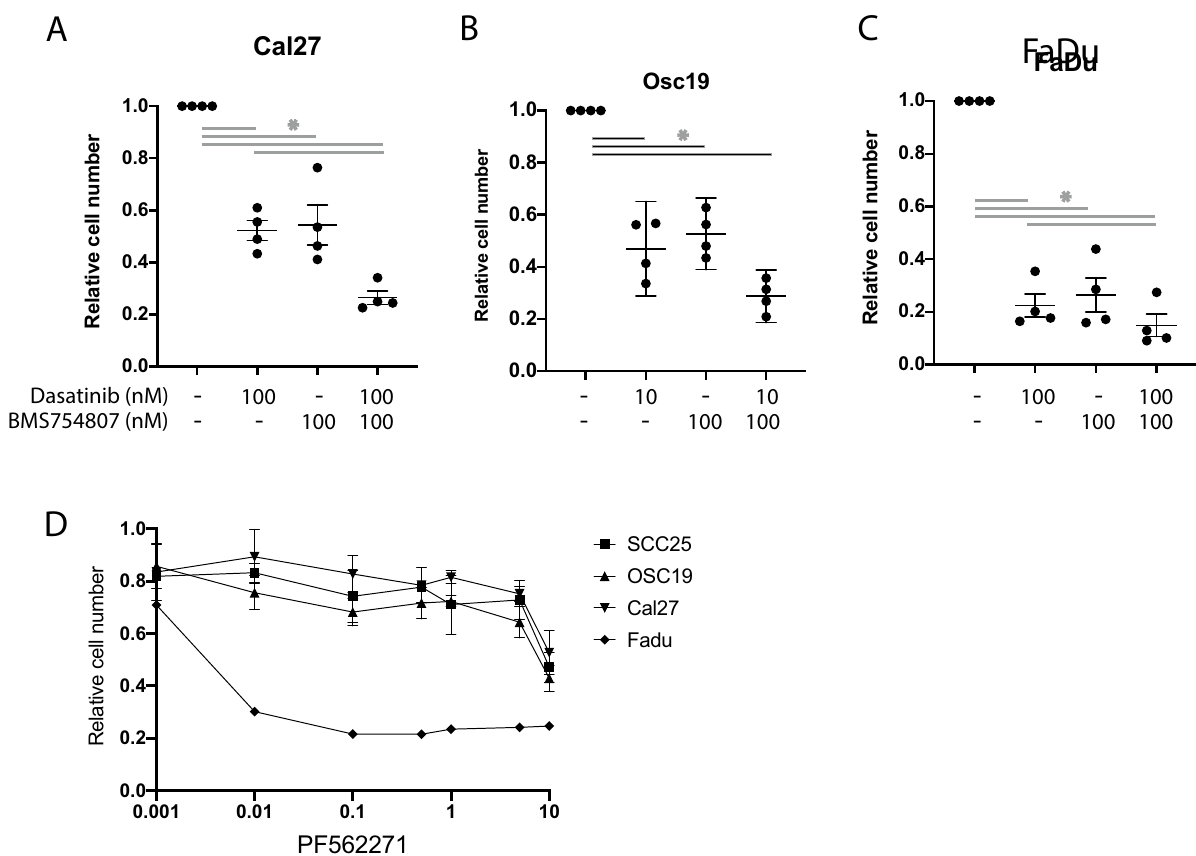
Figure 5. Inhibition of FAK, IGF1R and Src induces cytotoxicity in HNSCC spheroids. ( A – C ) Efficacy of BMS754807 and dasatinib on Cal27, Osc19, and FaDu on tumor spheroids following 7 days treatment. Data is presented as the mean ± SEM of 3–4 independent biological replicates. ( D ) PF-562,271 dose response of tumor spheroids. Asterisks represent p < 0.05 as determined by one-way ANOVA and Tukey post-hoc